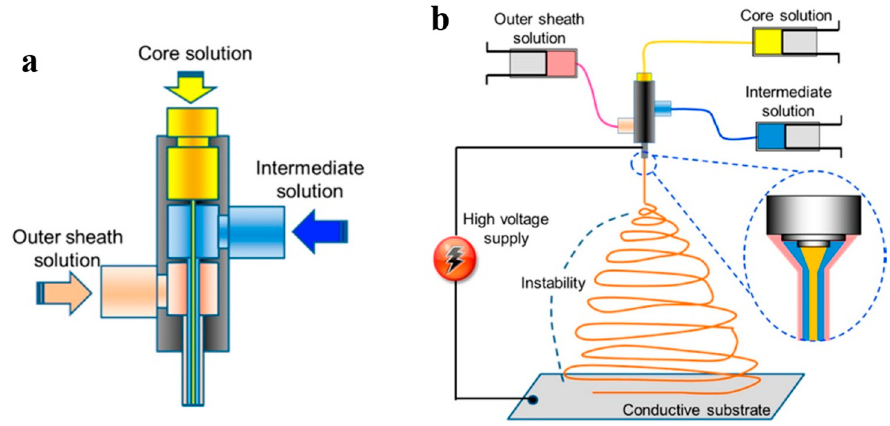
Figure 4. Triaxial electrospinning process: ( a ) triaxial spinneret; ( b ) basic mechanism (Reproduced with permission from [85]. American Chemical Society, 2017).